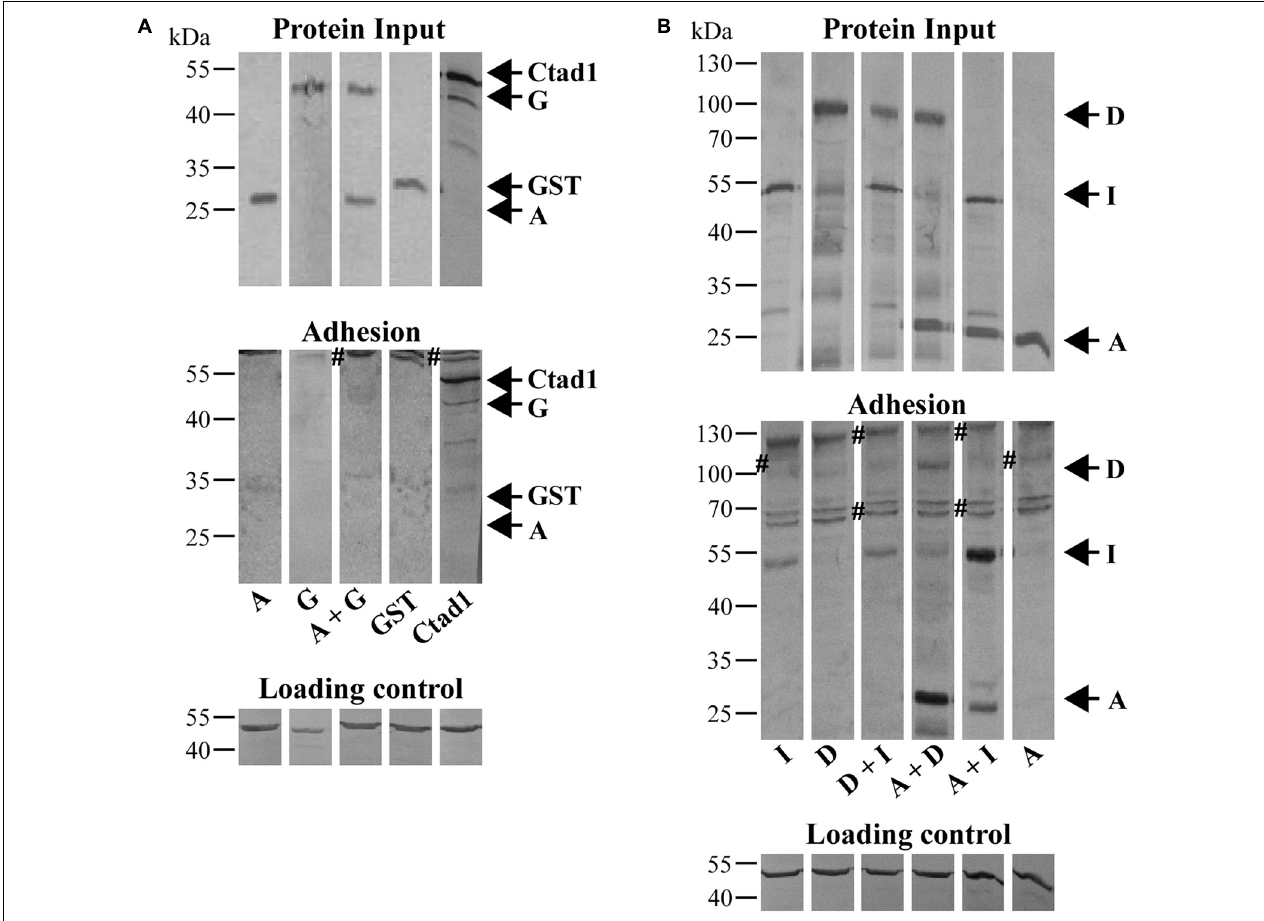
FIGURE 5 | Cell-binding affinities of homomeric and heteromeric Pmp oligomers. (A) Binding affinities for HEp-2 cells of homomeric A and G, and heteromeric A + G Pmp oligomers (100 µ g/ml). rGST and rCtad1 were used as negative and positive controls, respectively. (B) Binding affinities for HEp-2 cells of 100 µ g/ml homomeric A, D, and I, and heteromeric D + I, A + D, and A + I Pmp oligomers. Anti-actin was used to verify the amount of HEp-2 cells (Loading control), anti-His antibody to determine the total input of recombinant proteins (Protein input) and their binding ability (Adhesion). Symbol “#” indicates non-specific bands. Arrows mark the positions of the Pmps analyzed. Western blots bands are cut for clarity purposes. Representative original uncut pictures of (B) are shown in Supplementary Figure 7 . (A,B) All images are representative of three separate